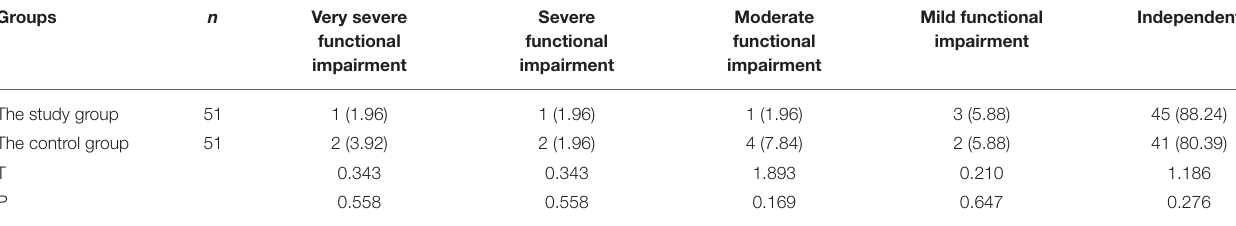
TABLE 4 | Comparison of activities of daily living in the two groups, n (%). Groups